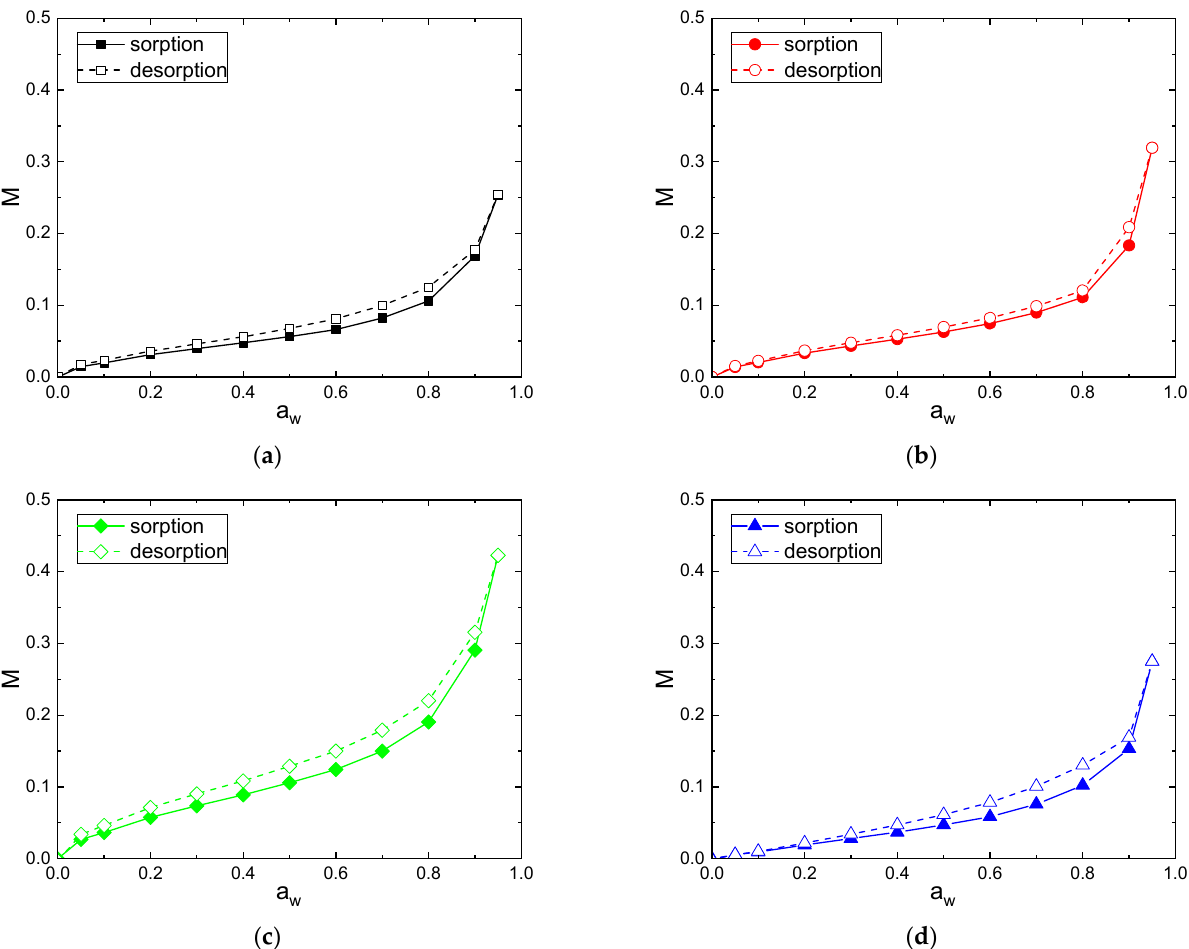
Figure 4. Water sorption and desorpton isotherms of: ( a ) C, ( b ) F, ( c ) V and ( d ) CA fibers.